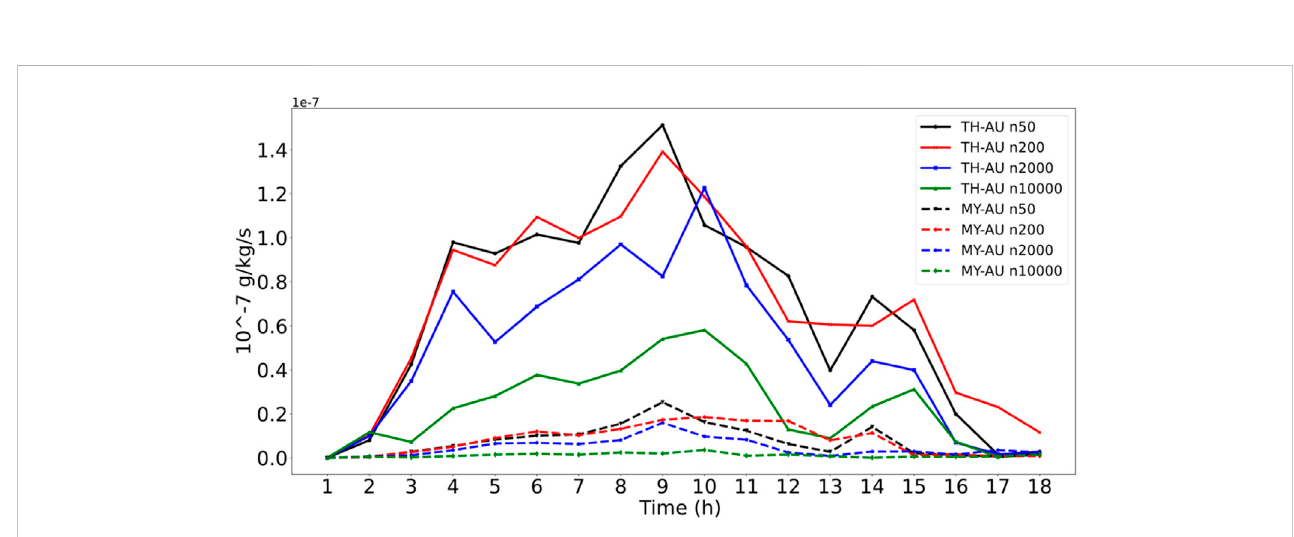
FIGURE 11 Time variation of auto-conversion rate from cloud water to rainwater (Unit: 10 – 7 g kg − 1 s − 1